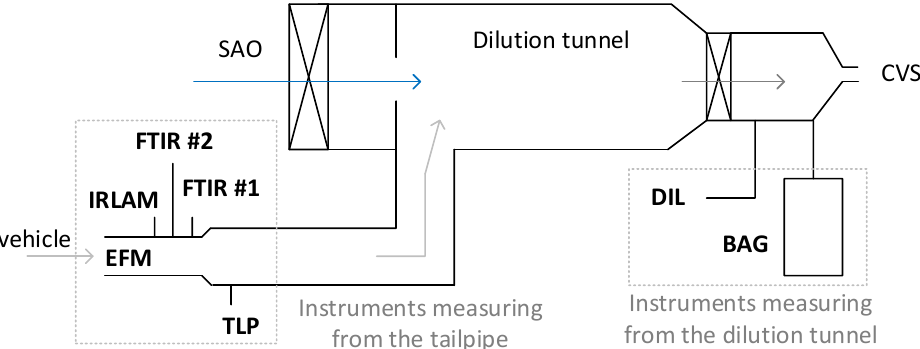
Figure 1. Experimental setup. BAG = bags; CVS = constant volume sampler; DIL = diluted; EFM = exhaust flow meter; FTIR = Fourier-transform infrared; IRLAM = infrared laser absorption modulation; SAO = smooth-approach orifice; TLP = tailpipe.